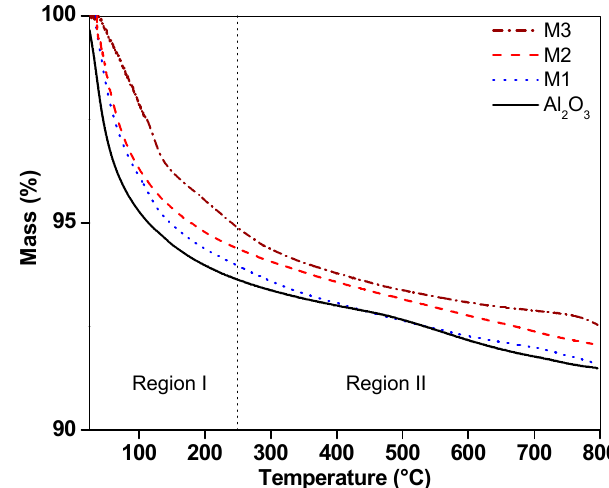
Figure 4. Thermogram for alumina and supported materials M1, M2 and M3 under a nitrogen atmosphere.